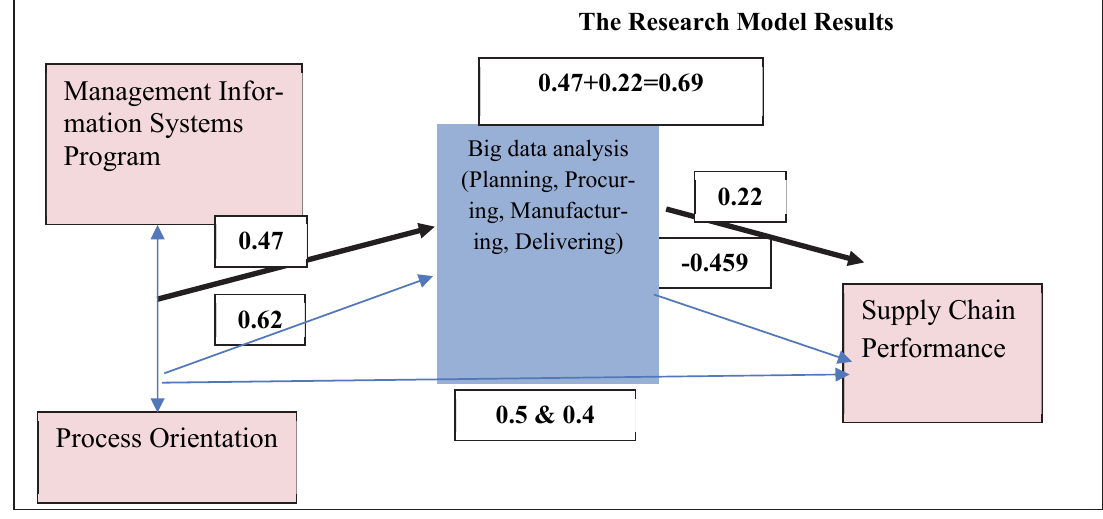
Fig. 2. The research model